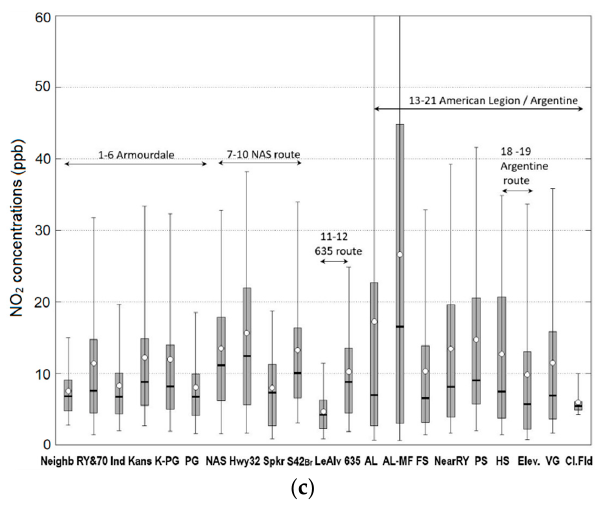
Figure 5. Distributions of observed concentrations of UFP ( a ), NO 2 ( b ), and BC ( c ) at the selected 21 mobile monitoring air quality zones.